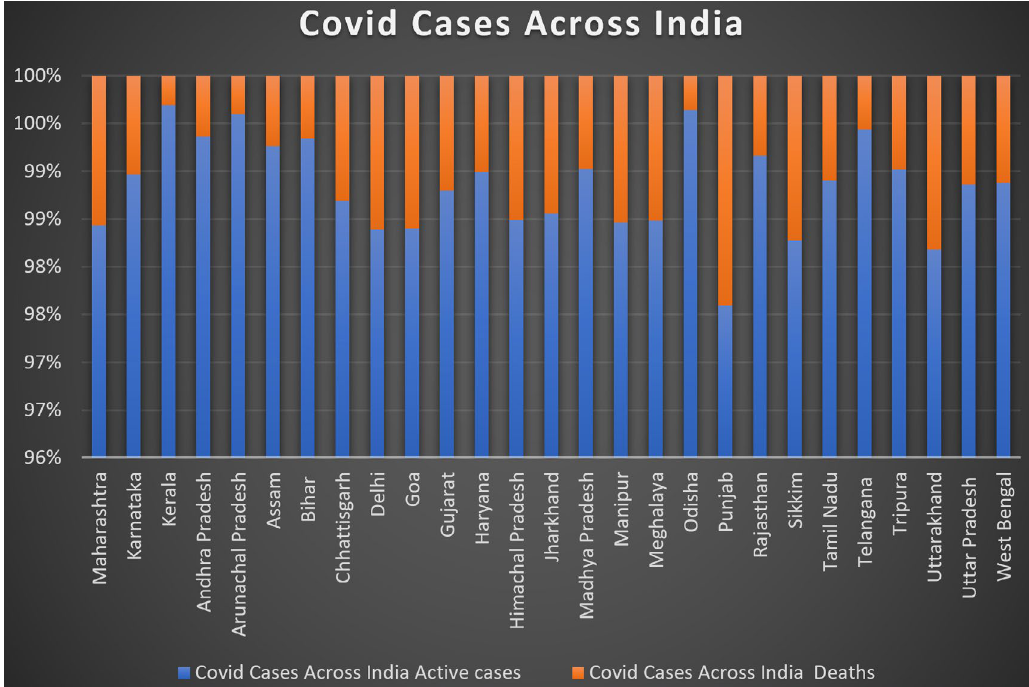
Fig. 4. Graphical representation of Covid cases across India (As on 24.05.2021) Data is adapted from, https://www.